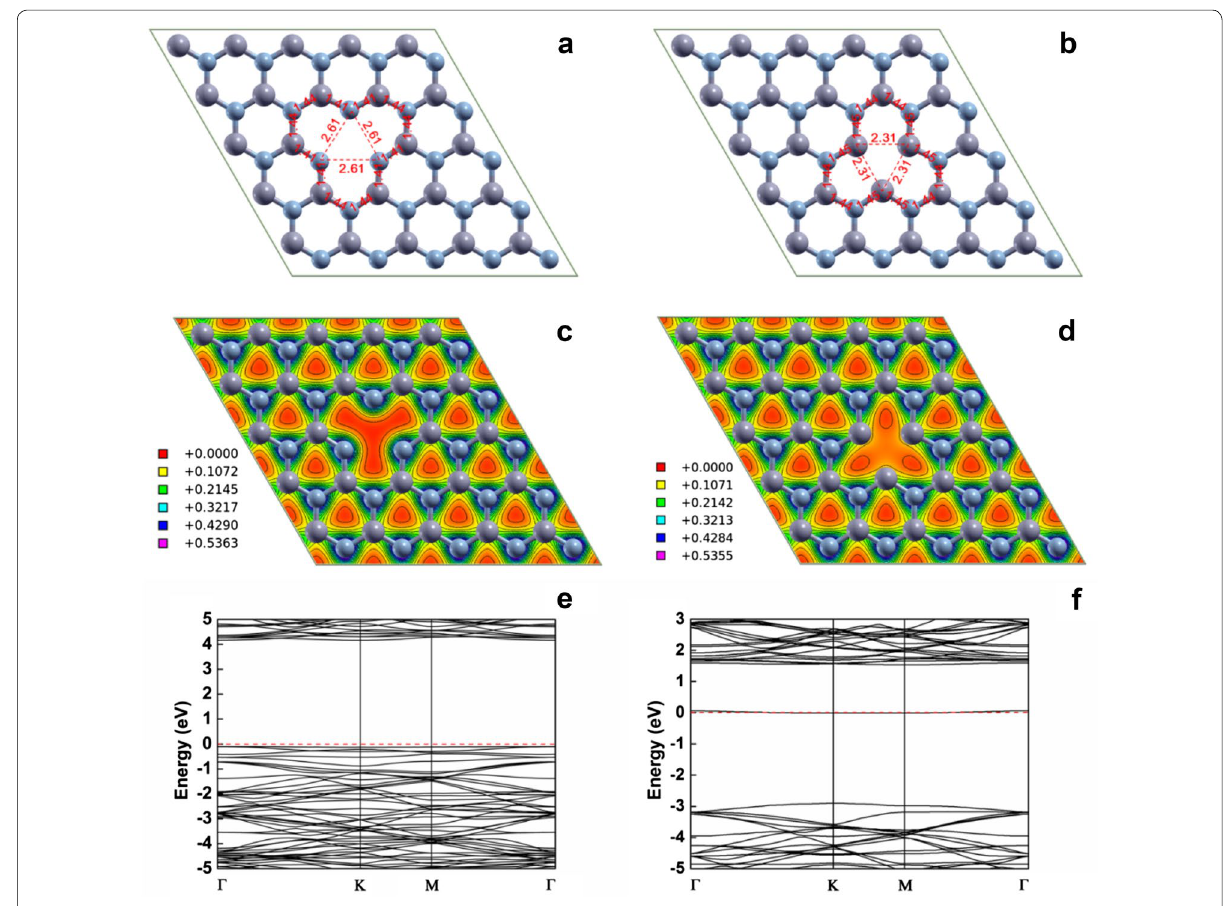
Fig. 3 The left column shows a relaxed structure, b isodensity plot, and c electronic band structure of h‑BN with 1V B , and the right column displays b relaxed structure, d isodensity plot, and f electronic band structure of h‑BN with 1V N . The Fermi level is set to be